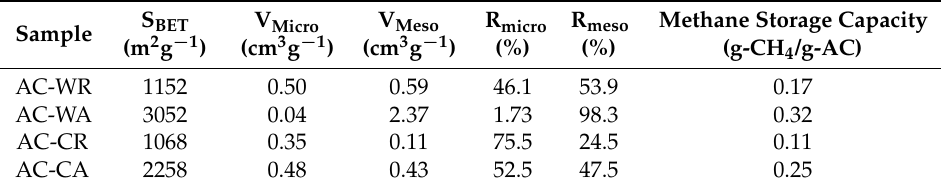
Table 2. Textural properties and methane storage capacity.